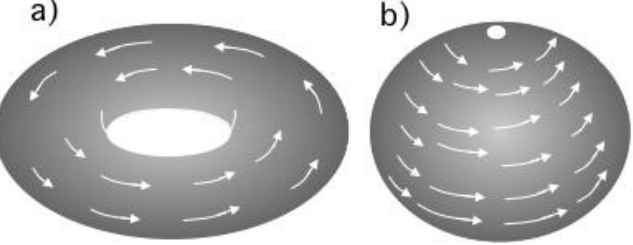
Figure 3. Characteristics of the vector fields in a torus and a sphere. It is possible to cover the torus with a non-zero vector field, but it is impossible to cover a sphere with a non-zero vector field (Brouwer’s fixed point